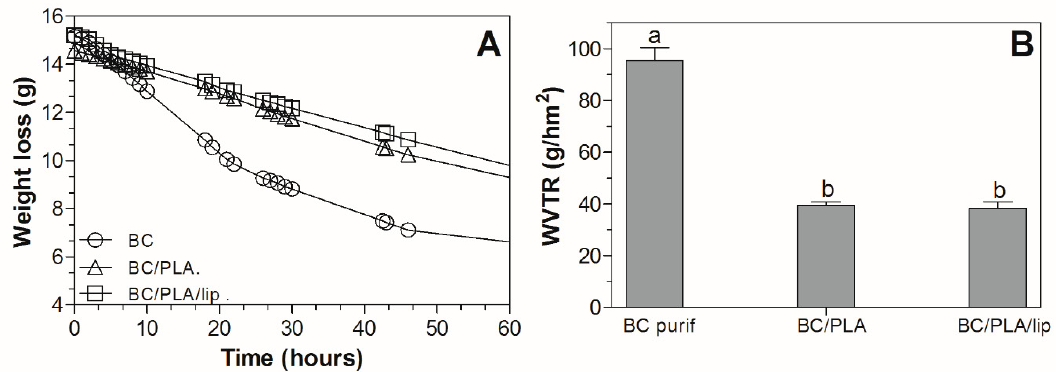
Figure 8. Weight loss as a function of time ( A ), WVTR values (g/hm 2 ) of the nanocomposites ( B ).